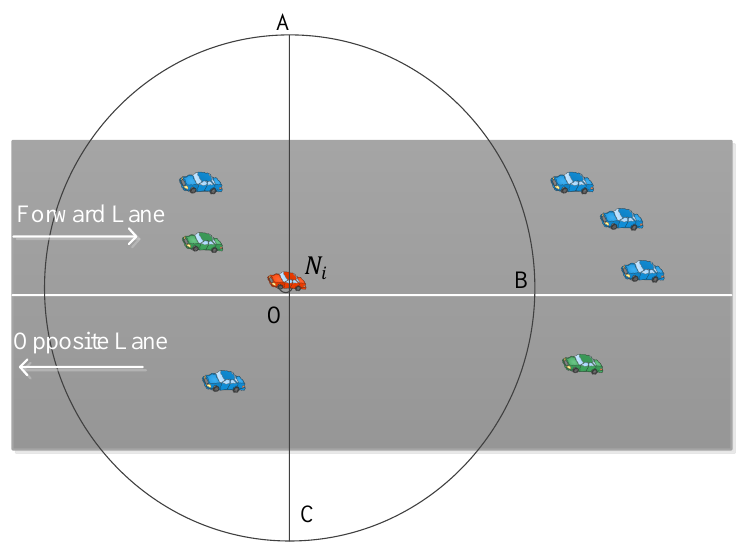
Figure 5. Re-caching by sending vehicle.